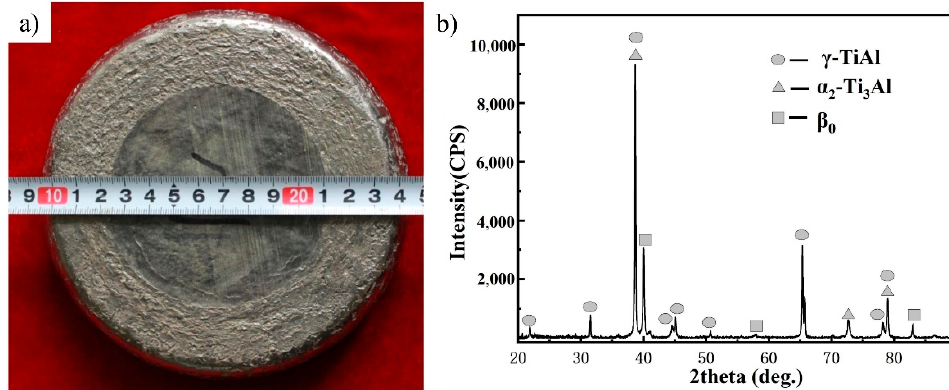
Figure 2. The appearance ( a ) and XRD pattern ( b ) of as-forged Ti–43Al–2Cr–0.7Mo–0.1Y alloy.